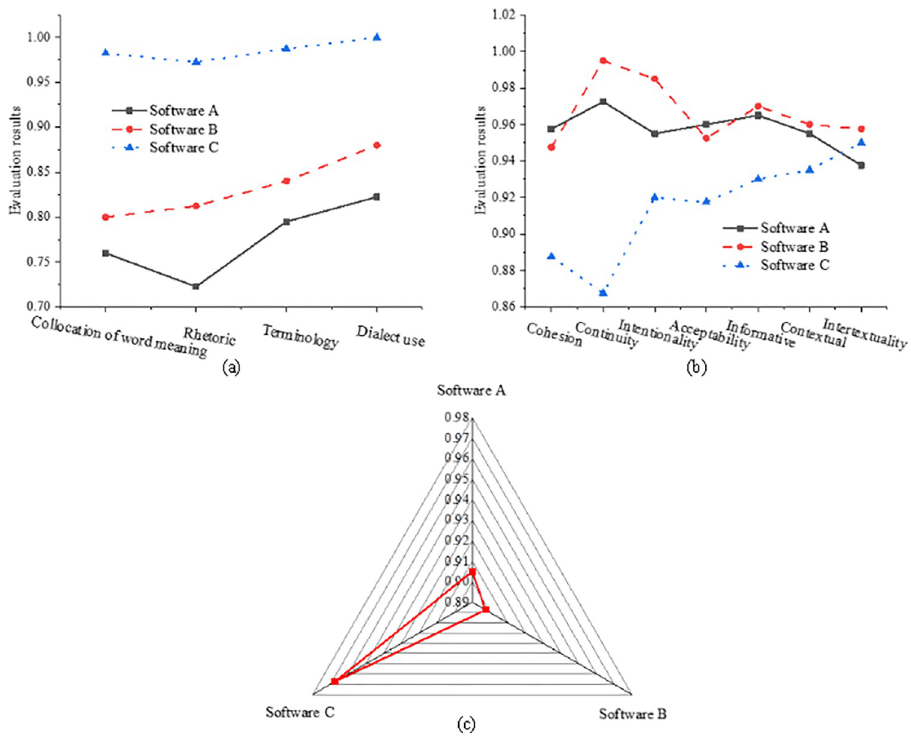
Fig 10. Automatic evaluation results of the TQA model. a: vocabulary; b: discourse; c: grammar.